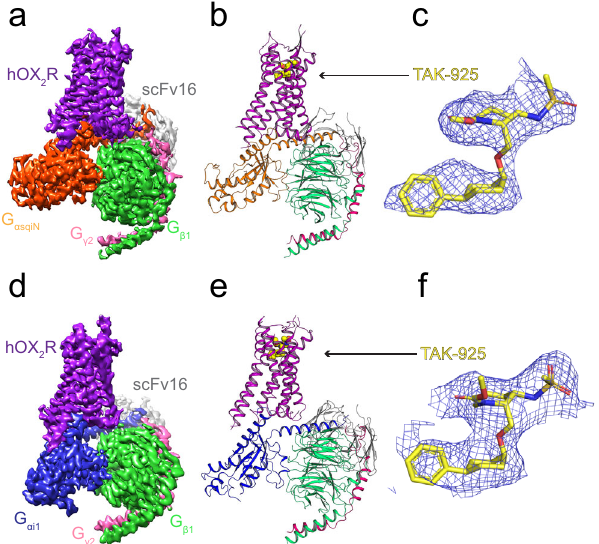
Fig. 1 Overall structures of the OX 2 R-G protein complexes. a Cryo-EM reconstruction of the complex OX 2 R-mG sqiN . Receptor density is in purple, TAK-925 is yellow, G α sqiN is orange, G β 1 is green, G γ 2 is pink. The cryo-EM density from Relion was displayed in Chimera as colored surfaces (contour level 0.033, 5 sigma), where different colored zones corresponded to the different polypeptides. b Model of complex as a cartoon, with the TAK-925 agonist as spheres with yellow carbons, blue nitrogens and red oxygens. c Cryo-EM density surrounding the ligand TAK-925 in the complex structure OX 2 R-mG sqiN , with the TAK-925 agonist as sticks with colored by heteroatom (yellow carbons, blue nitrogens and red oxygens). Cryo-EM density was displayed in Pymol (4.2 sigma) within 2 Å around TAK-925. d Cryo-EM reconstruction of the complex OX 2 R-G i1 . Receptor density is in purple, TAK-925 is yellow, G α i1 is blue, G β 1 is green, G γ 2 is pink. The cryo- EM density from cryoSPARC was displayed in Chimera as colored surfaces (contour level 0.5, 5 sigma), where different colored zones corresponded to the different polypeptides. e Model of complex as a cartoon, with the TAK- 925 agonist as spheres with yellow carbons, blue nitrogens and red oxygens. f Cryo-EM density surrounding the ligand TAK-925 in the complex structure OX 2 R-G i1 , with the TAK-925 agonist as sticks with colored by heteroatom (yellow carbons, blue nitrogens and red oxygens). Cryo-EM density was displayed in Pymol (5 sigma) within 2 Å around